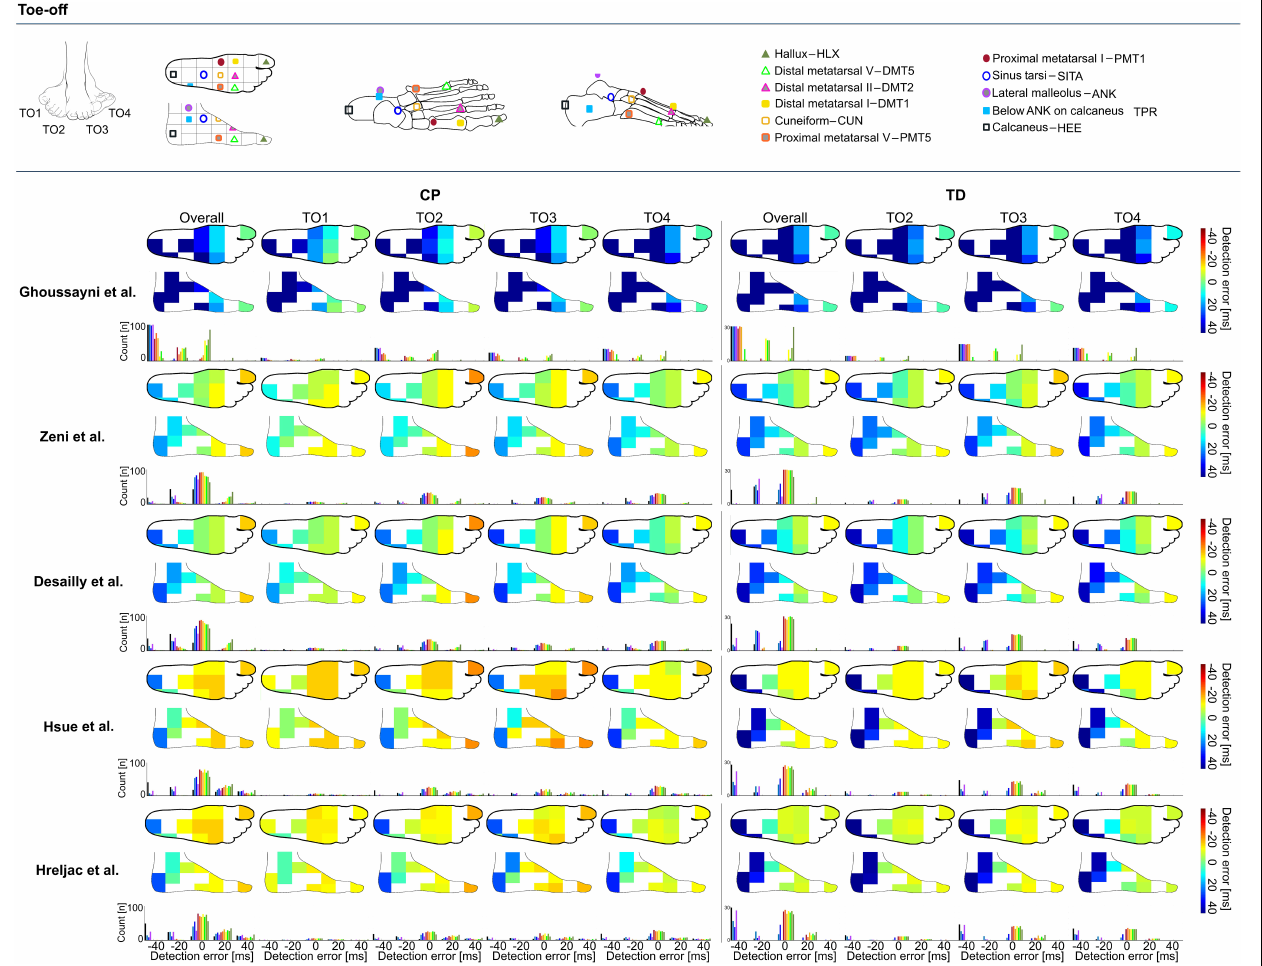
FIGURE 2 | Heatmaps showing median detection errors for estimating the timing of toe-off (TO) for individuals with CP and TD. The location of the markers is indicated on top of the figure, each marker location is connected to a pixel on the heatmap. The color of the heatmap indicates the median detection error. The histogram below each heatmap indicates the number of individuals for which a certain detection error was obtained. Groups TO1–TO4 were based on angle of the foot in the sagittal plane during midstance, Supplementary Table 1